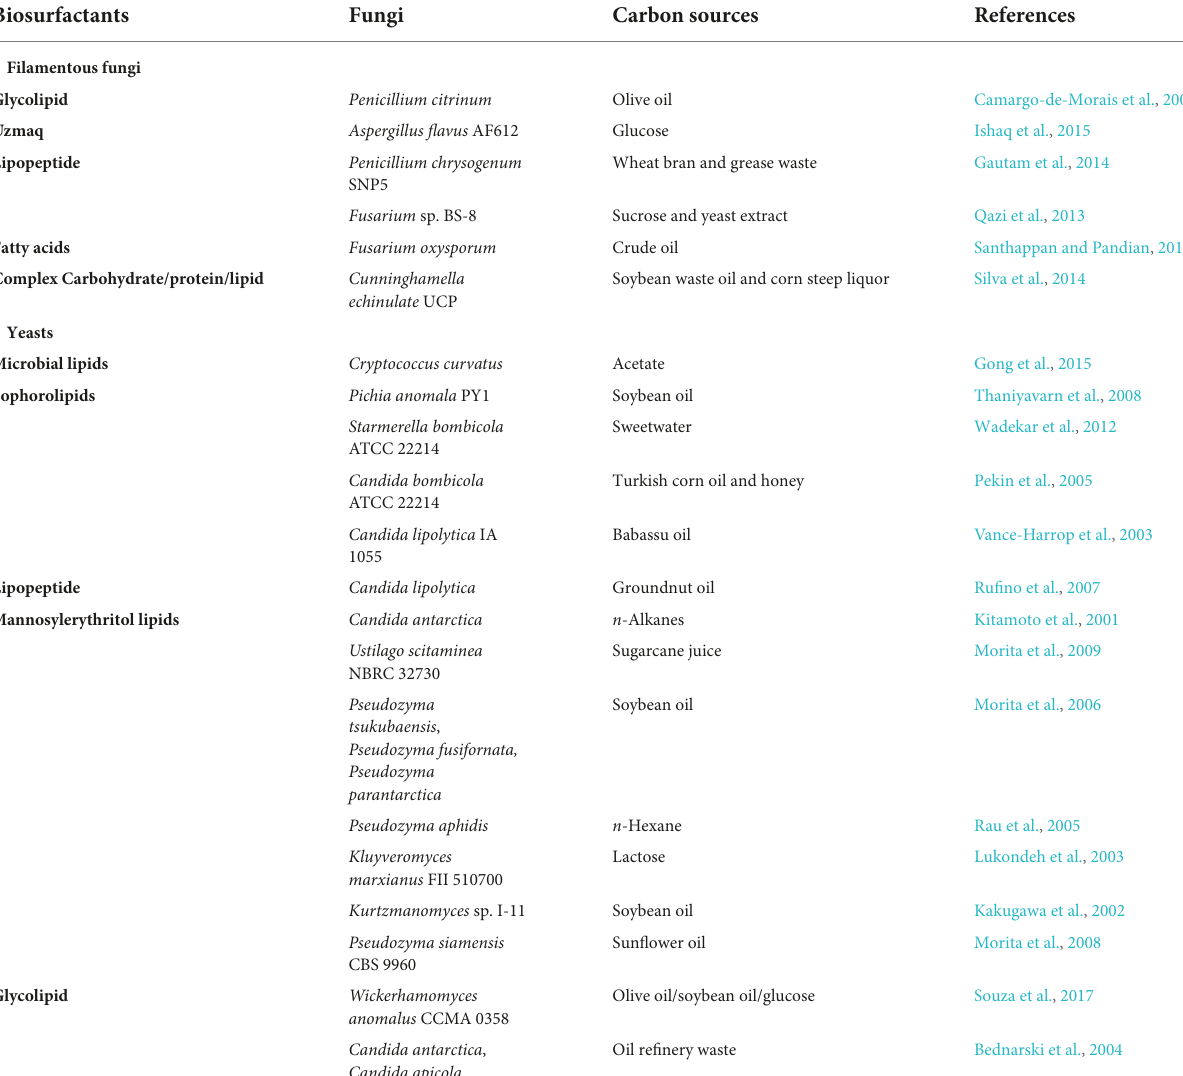
TABLE 2 Fungal strains producing